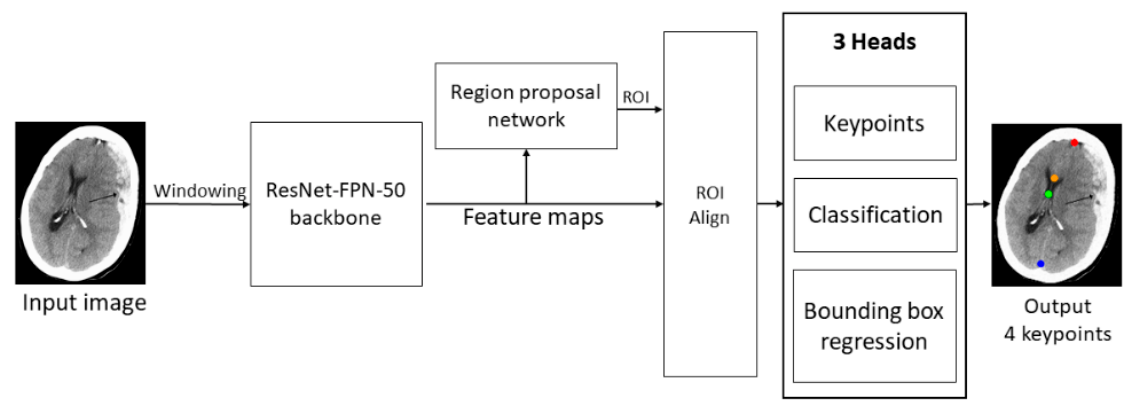
Figure 2. The architecture of Keypoint R-CNN. The Kepoint R-CNN contains ResNet-FPN-50 as a backbone, a region proposal network as a ROI generator, and three heads to realize the automatic detection of MLS.